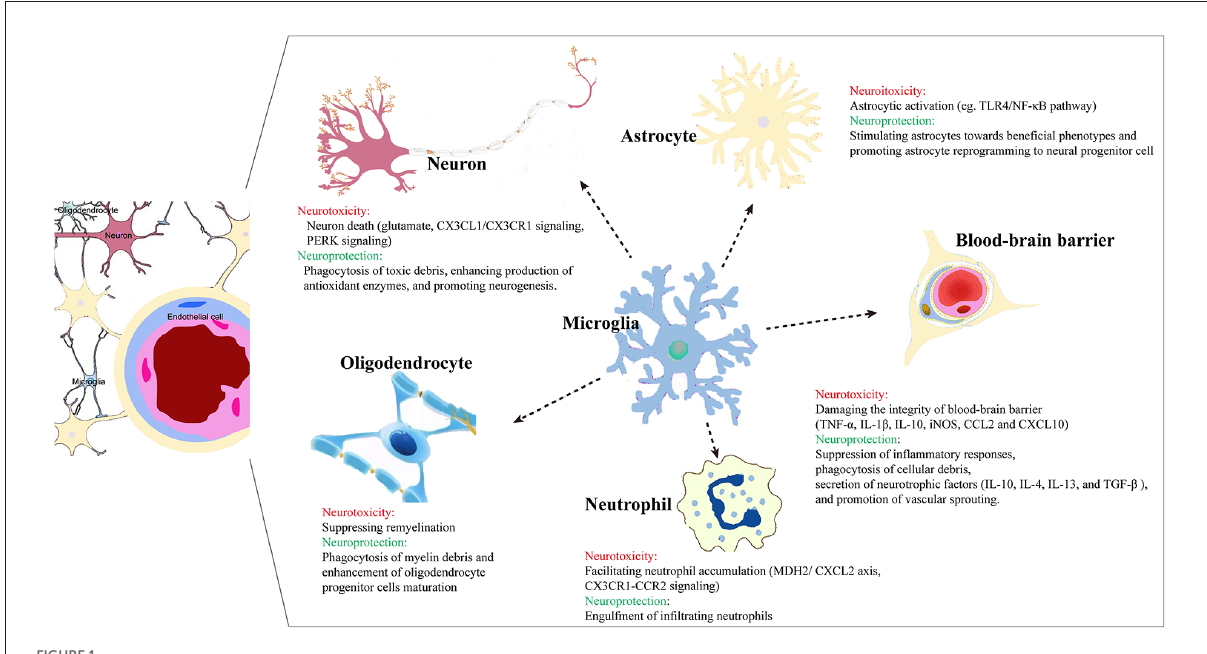
FIGURE1 Microglia crosstalk with other cells in the brain post ischemic